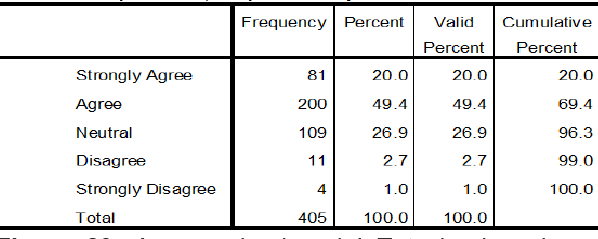
Figure 29. As our cloud and IoT technology has resulted in coordination among departments, our production process has